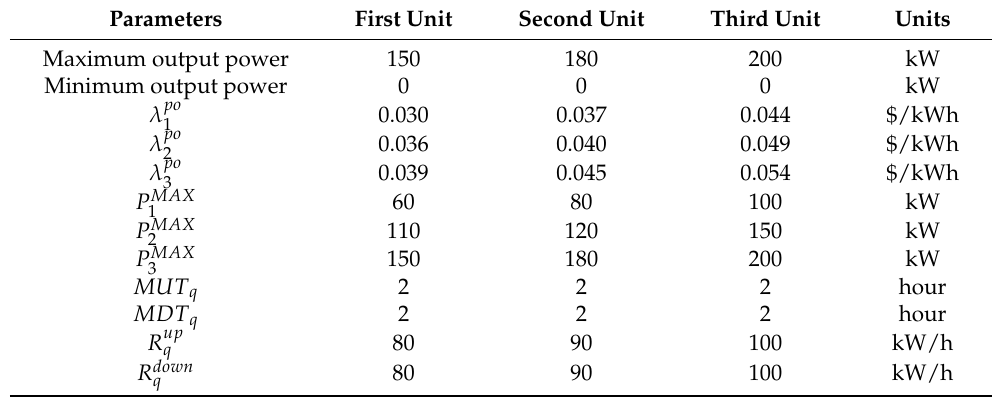
Table 3. Parameters of power-only